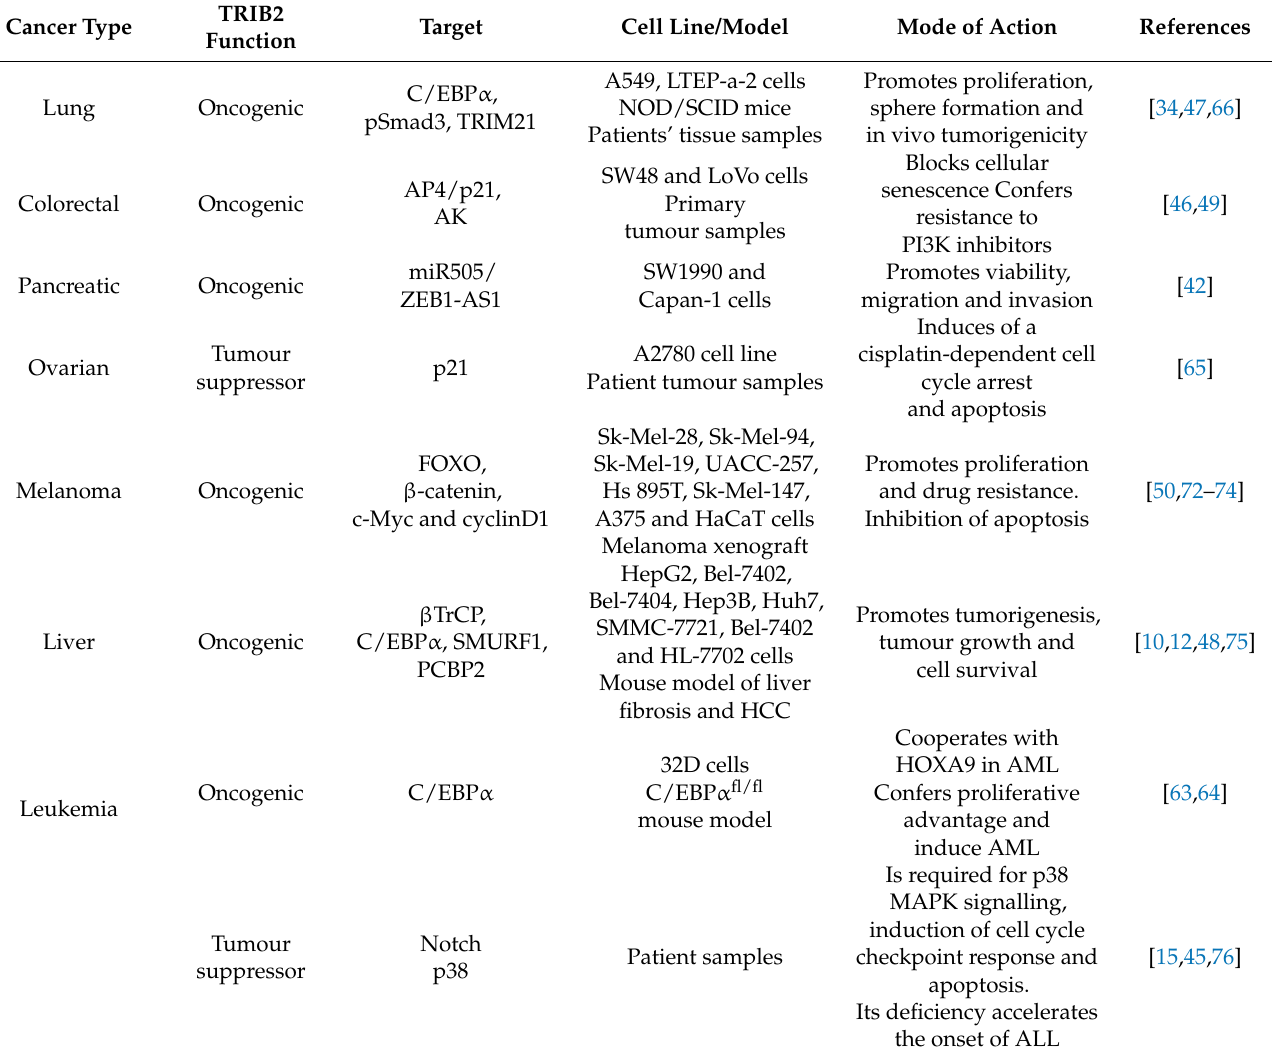
Table 2. Summary of TRIB2 function in different human